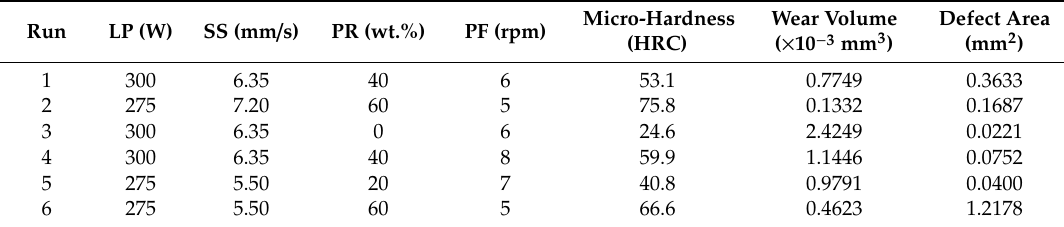
Table A1. Central composite design (CCD) experimental design and